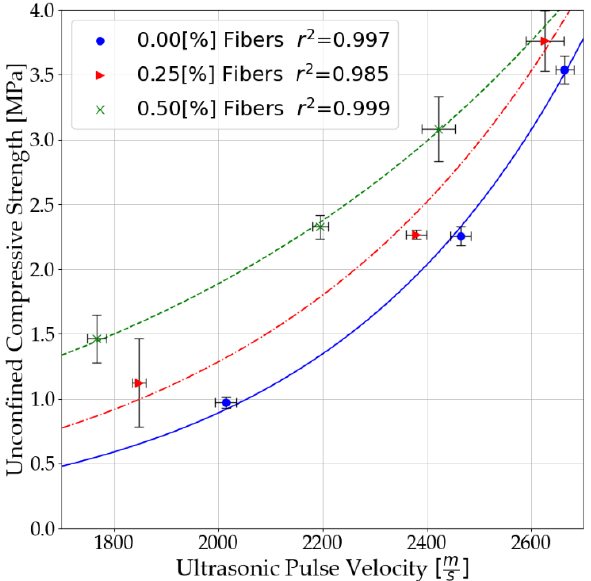
Figure 8. Relationship of ultrasonic pulse velocity and unconfined compressive strength after 28 days of curing of mixtures.